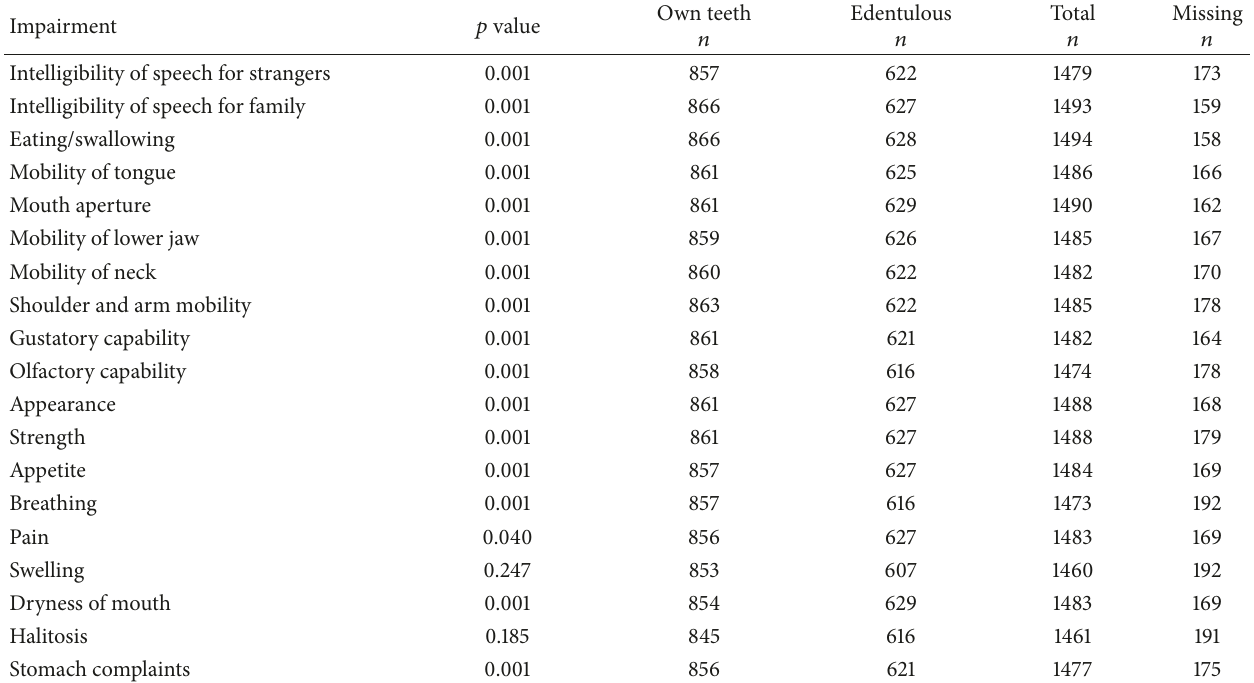
Table 3: Comparisons of the more serious impairments between edentulous patients and patients with remaining teeth after treatment for oral squamous cell carcinoma ( 𝑛 = 1652